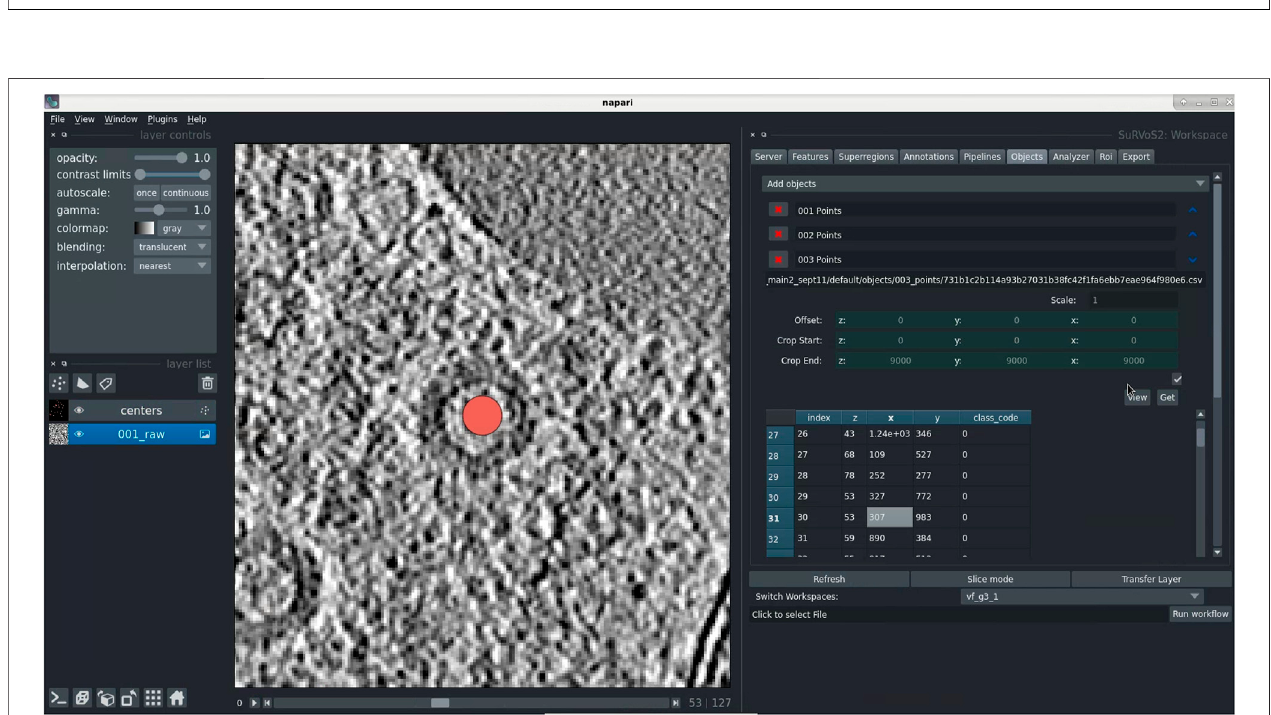
FIGURE6| UseofgeometricdatainSuRVoS2toanalyzecrowdsourcedannotations. (A) DatawereimportedintotheNapariviewerusingasimpleCSV fi leformat indicating 3D centroid locations and object class. The tools in SuRVoS2 can be used to visualize, edit, and delete geometric data, including a function to take the user directly to an object of interest by double clicking on its entry in the table view.